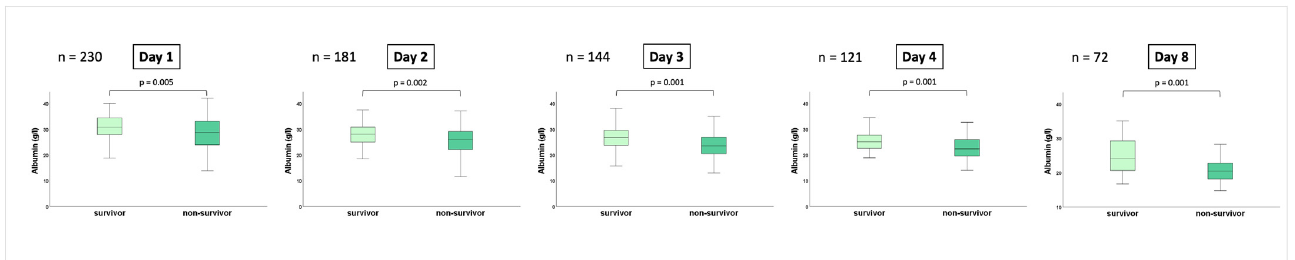
Figure 1. Box plots demonstrating the distribution of albumin among 30-day survivors and non- survivors with CS during the first 8 days of CS onset (i.e., on days 1, 2, 3, 4, and 8). The data are presented as the median with interquartile ranges (boxes) and 5–95% percentiles (whiskers). Table 4. Prognostic performance of the albumin level on days 1, 2, 3, 4, and 8, analyzed as the area under the curve (95% CI).